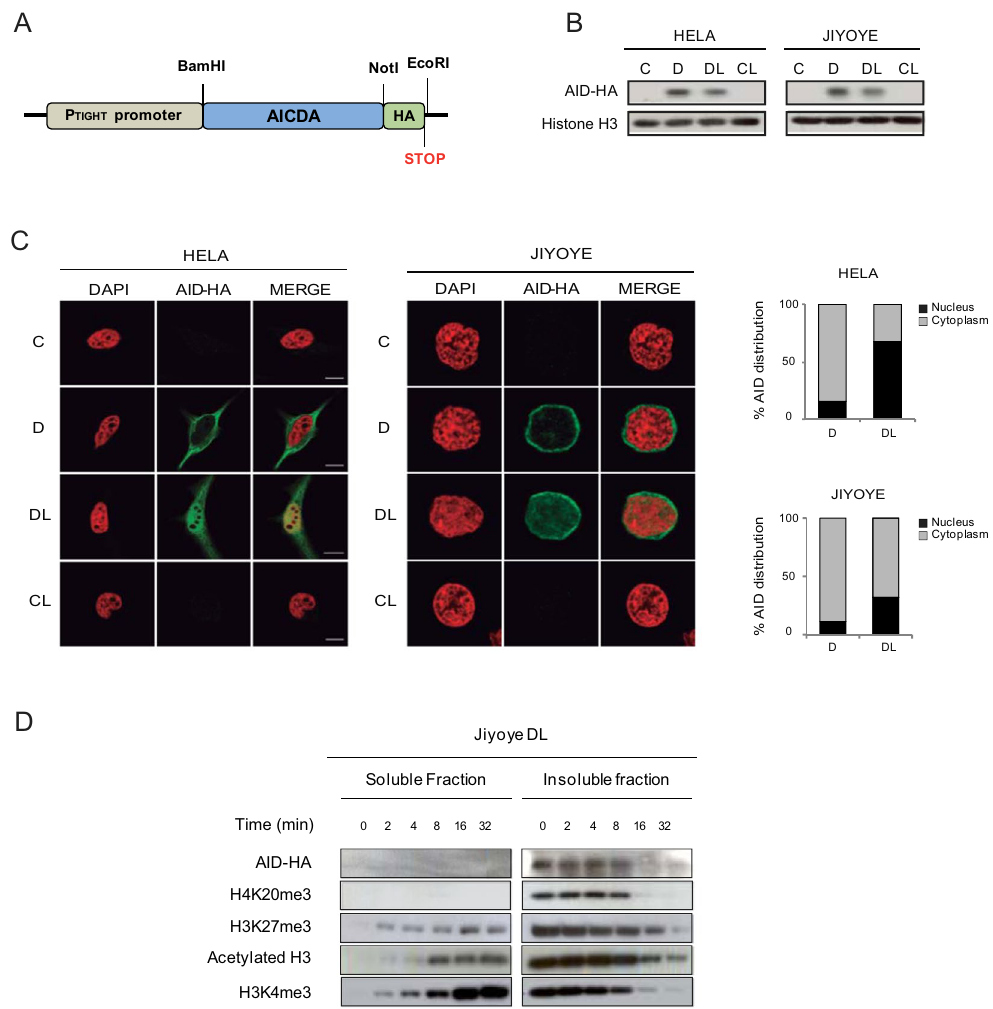
Figure 1. An inducible system for AID expression and accumulation in the nucleus. ( A ) Representative scheme of the HA-tagged AID retroviral construct. ( B ) AID expression is induced following doxycycline (D) treatment and retained in the nucleus upon additional treatment with leptomycin B (L), which specifically inhibits nuclear export. Anti-HA antibody was used to detect AID expression and histone H3 was used as a loading control ( C ) Representative confocal images of AID subcellular localisation in HeLa and Jiyoye cells after doxycycline and leptomycin B treatment. Nuclear DNA was counterstained with DAPI (red). A total of 25 cells from randomly selected fields were analysed in each experimental condition. The graphs in the right show the quantification of the cellular signal of AID within the cells. Light gray section of the bar indicates the average percentage of cytoplasmic AID signal. Black section of the bar indicates the average percentage of nuclear AID signal. ( D ) Association of AID with heterochromatin. Time course digestion of HA-tagged AID Jiyoye cells nuclei with DNase I, in which the supernatant contains the euchromatin fraction (as demonstrated by the appearance of H3Ac and H3K4me3) and the pellet contains the heterochromatin fraction (as shown by the progressive decrease of H4K20me3 and